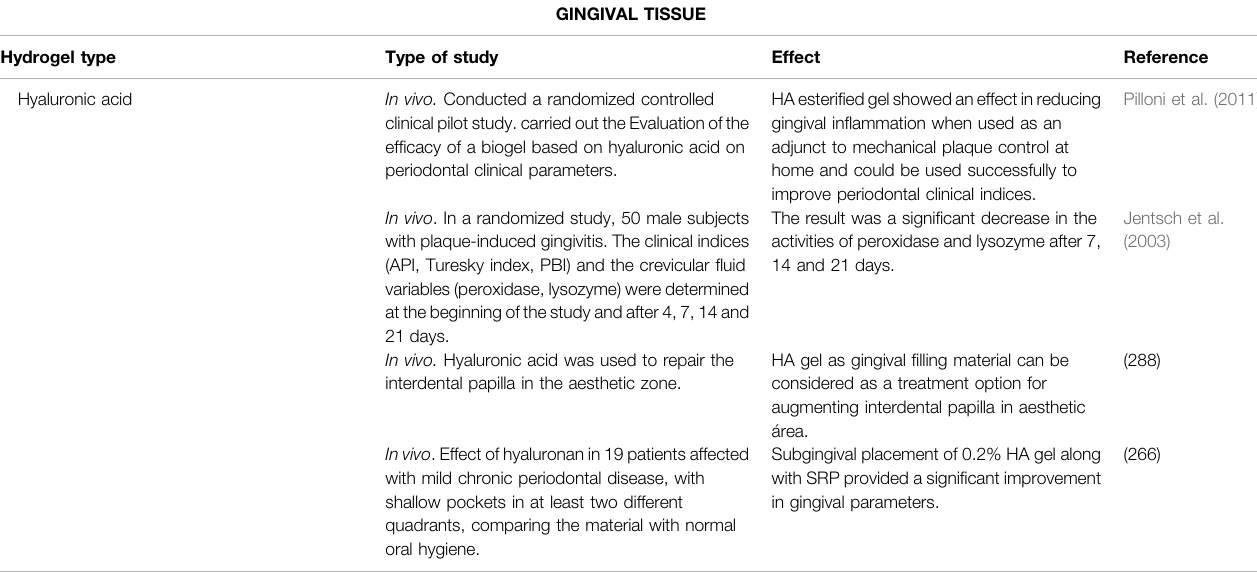
TABLE 2 | ( Continued ) Hydrogel-based scaffolds for periodontal tissue